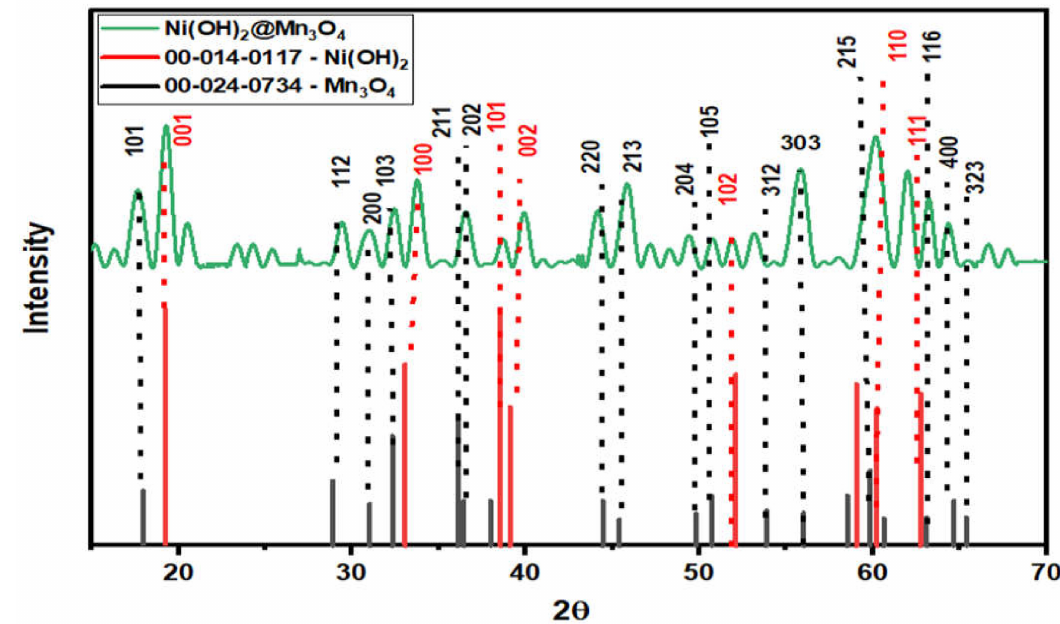
Figure 4. XRD diffraction pattern of Ni(OH) 2 @Mn 3 O 4